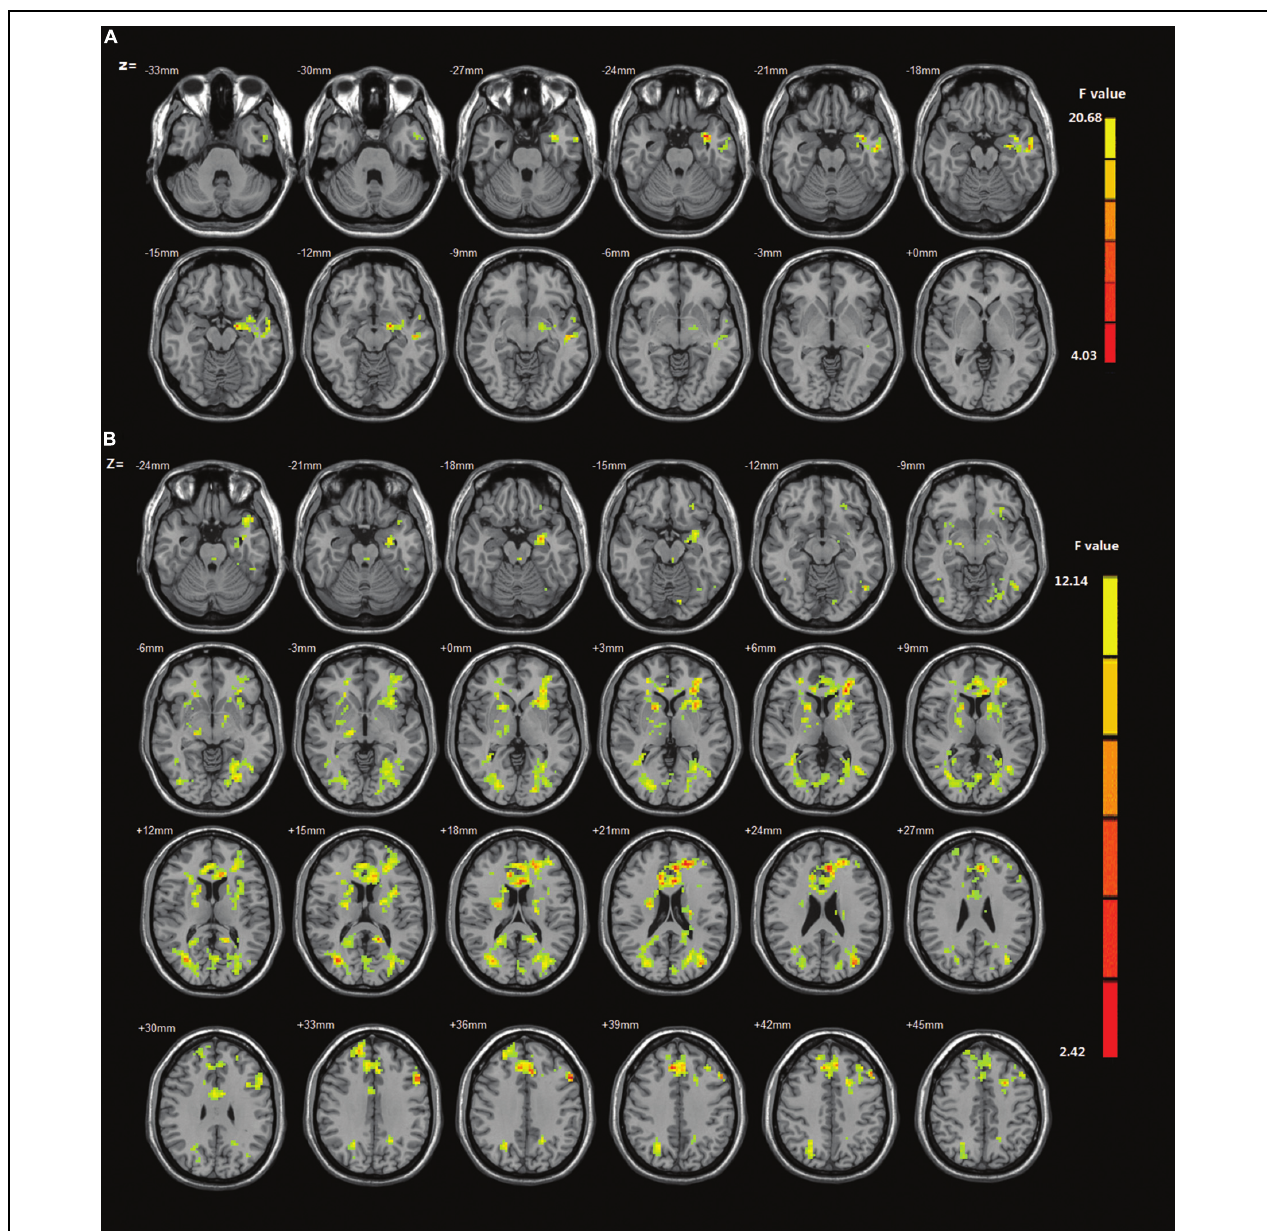
FIGURE 1 | (A) The main effect for group on amplitude of low-frequency fluctuation (ALFF). Brain regions in which the fractional amplitude of low-frequency fluctuation (fALFF) is different between Internet gaming disorder (IGD) and healthy controls. The IGD subjects showed increased ALFF in warm colored brain regions especially the cerebellum, whereas decreased ALFF in cool colored regions including the superior temporal gyrus. Map threshold of multiple comparisons were set at p < 0.05 using AlphaSim correction. (B) The interaction between frequency band and group on fALFF. The results were obtained by a two-way repeated-measures analysis of variance (ANOVA) calculated by